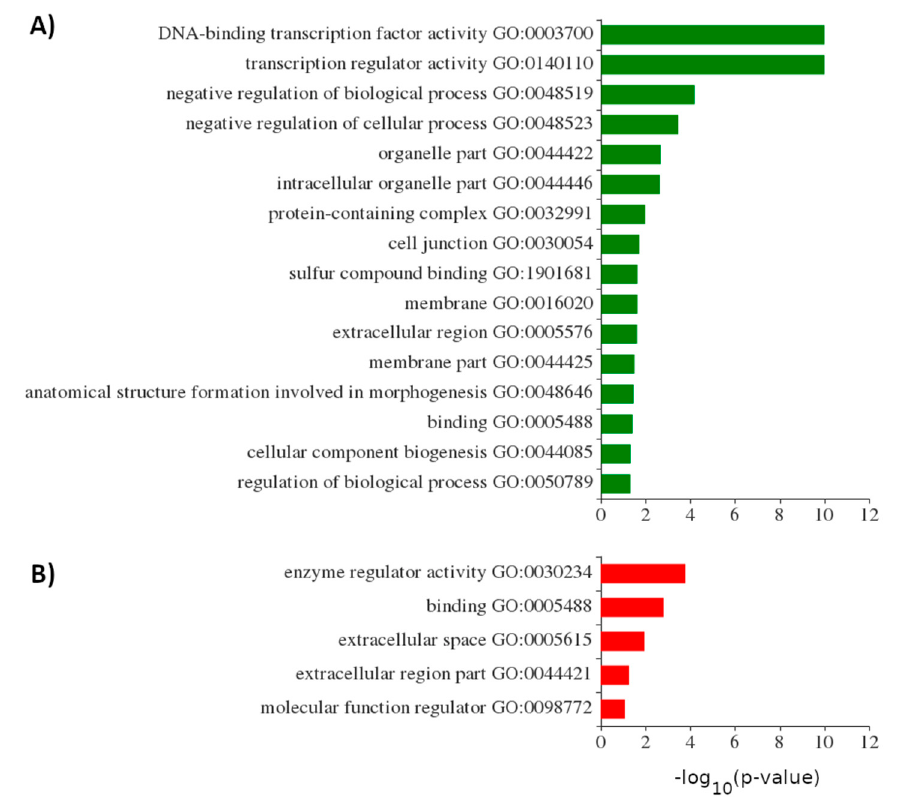
Figure 4. Gene ontology (GO) of co-expressed pairs of putative autonomous 3 ′ UTRs and protein coding transcripts (PCTs) from the same mRNA that were upregulated ( A ) or downregulated ( B ) after microcystin-LR (MC-LR) exposure. Figure shows enriched ( A ) or depleted ( B ) gene ontology terms for pairs that were upregulated ( A ) or downregulated ( B ) at 1 day compared to 6 and 9 days. Horizontal bars represent the corresponding p -values of each regulated transcript pairs, p < 0.05.